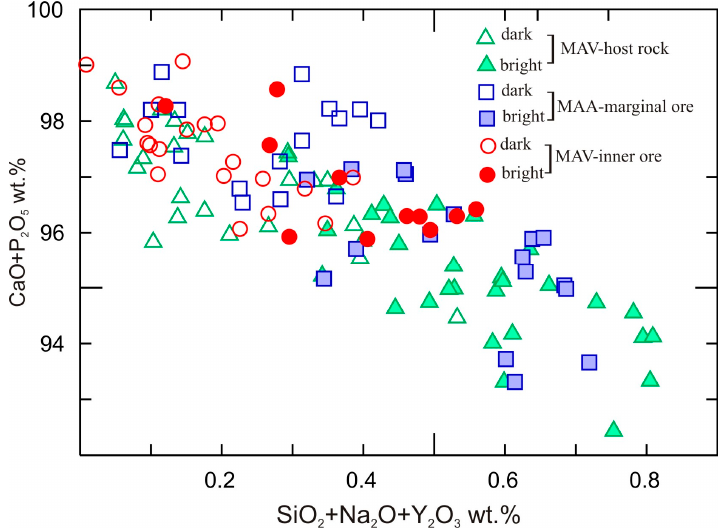
Figure 10. SiO 2 + Na 2 O + Y 2 O 3 versus CaO + P 2 O 5 plot of Chadormalu apatites.